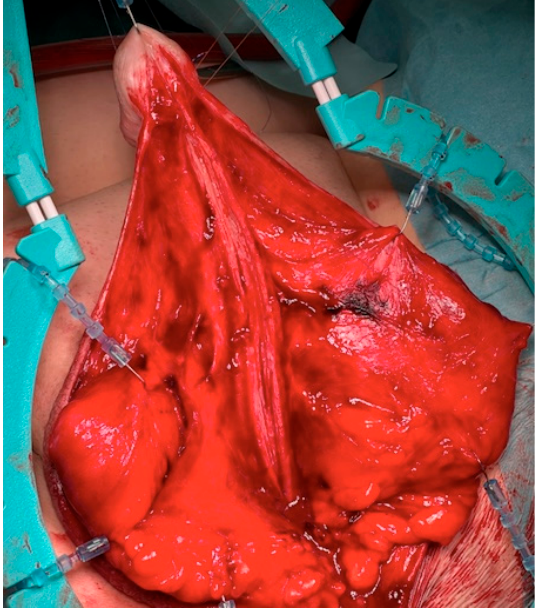
Figure 1. The stricturated urethra is opened and the entire stricture is split.